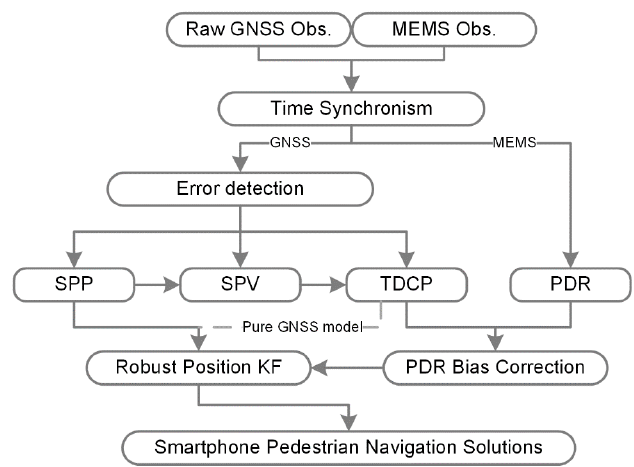
Figure 4. Architecture of the fusion algorithm of GNSS and Pedestrian Dead Reckoning (PDR).